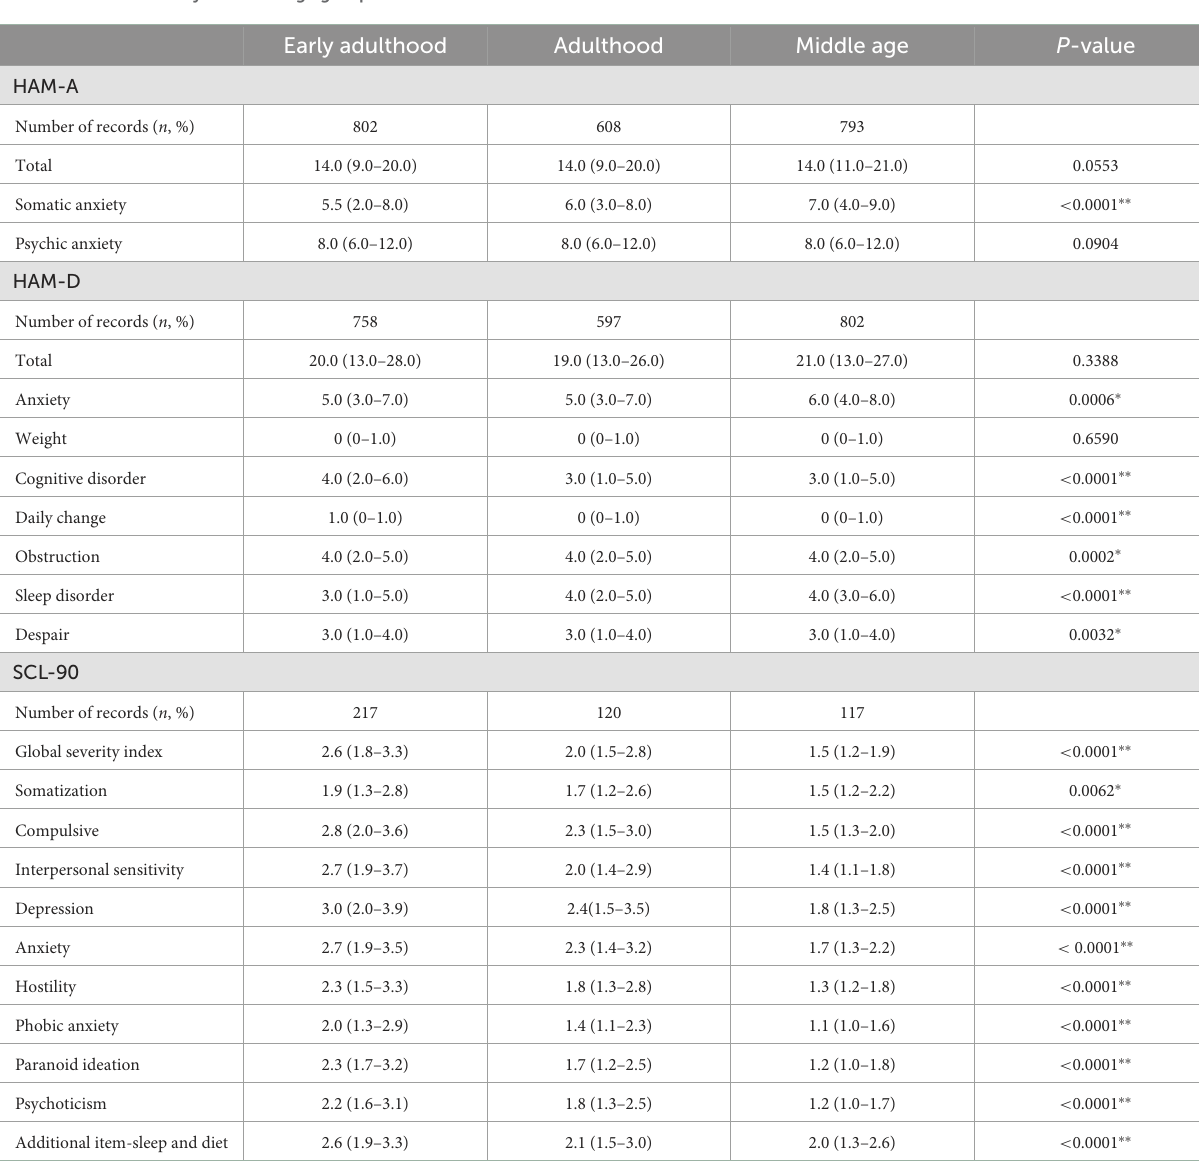
TABLE 3 Mann–Whitney U test for age groups. Early adulthood Adulthood Middle age P